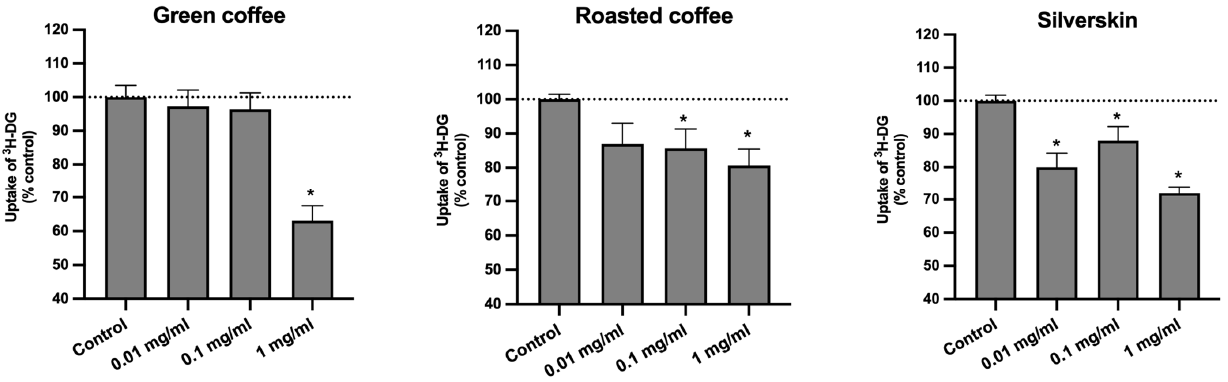
Figure 2. Effect of green coffee, roasted coffee, and coffee silverskin extracts on the uptake of 3 H-DG by Caco-2 cells. Caco-2 cells were cultured for 24 h in the presence of different extract concentrations ( n = 6–9) or the respective solvent (control; n = 7–9). Uptake was measured by incubating Caco-2 cells at 37 °C with 10 nM 3 H-DG for 6 min. Results are expressed as means ± SEM. *, significantly different from control ( p < 0.05; Student’s t -test).